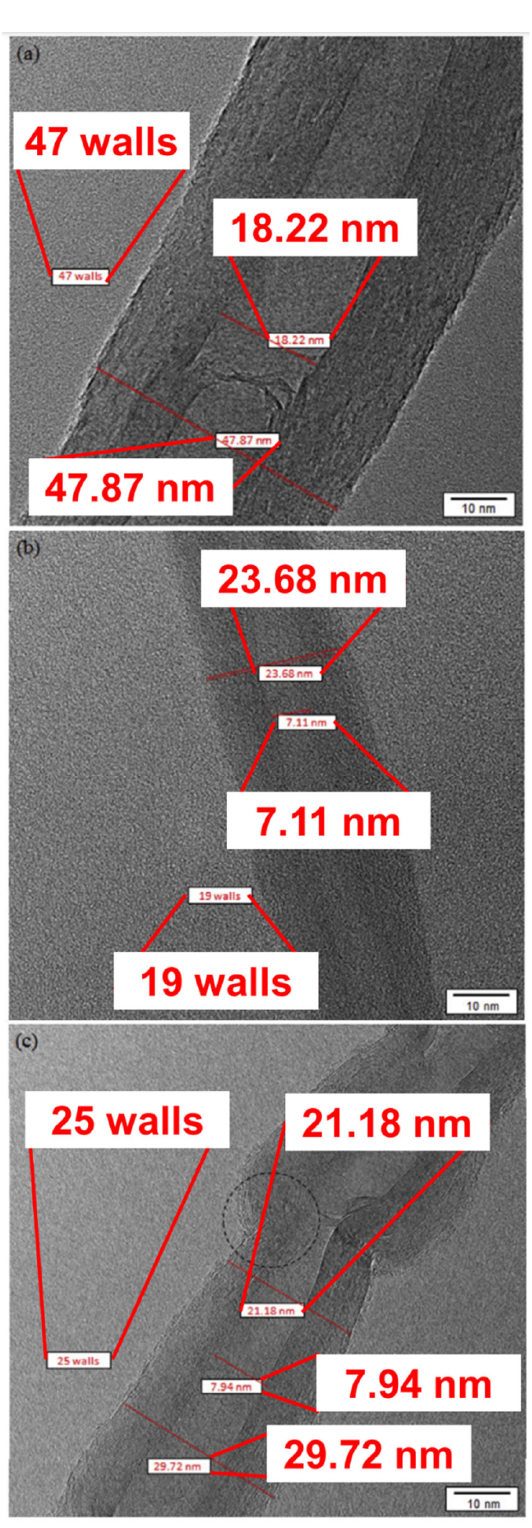
Figure 11. HR ‐ TEM images of the various MWNT allotropes formed on ( a ) Ni/Zr, ( b ) Ni/LaZr, and ( c ) Ni/CeZr during 50 h DRM at 750 °C and constant WHSV= 40,000 mL g − 1 h − 1 . Reprinted with ( c ) Ni/CeZr during 50 h DRM at 750 ◦ C and constant WHSV = 40,000 mL g − 1 h − 1 . Reprinted with permission from Ref. [76]. Copyright 2018 Elsevier. permission from Ref. [76]. Copyright 2018